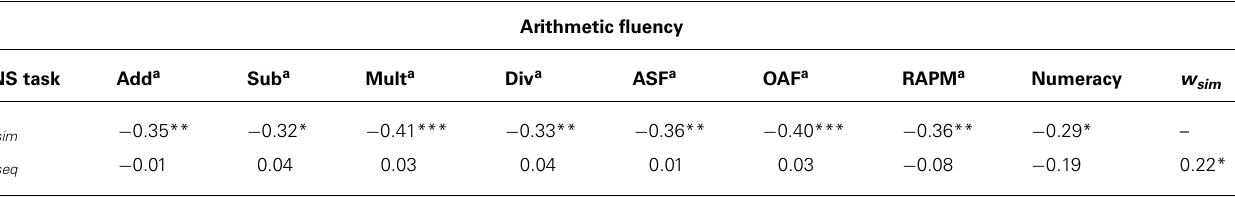
Table 1 | Pairwise correlations (Pearson correlation) between the simultaneous ( w sim ) and sequentialANS measure ( w seq ) and performance on addition (Add), subtraction (Sub), multiplication (Mult), addition/subtraction fluency (ASF-addition and subtraction combined), division